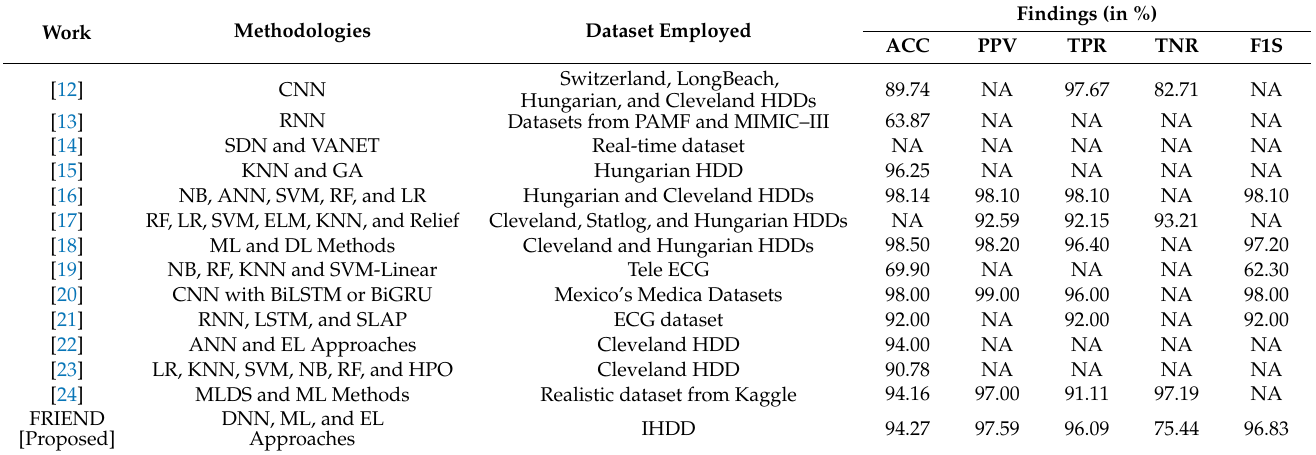
Table 9. Comparison of FRIEND with some considered state-of-the-art works based on performance parameters findings.